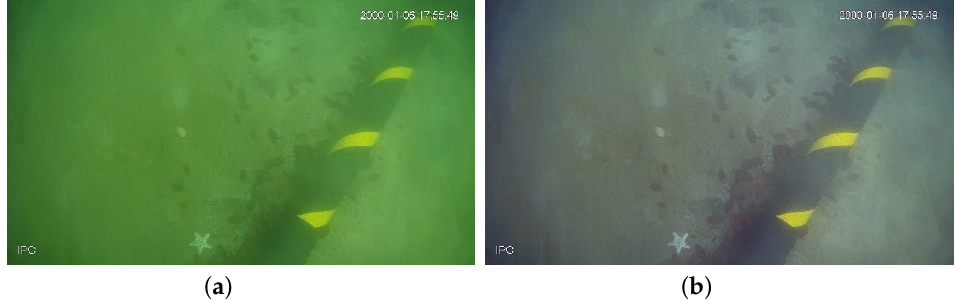
Figure 2. Example of the sample colour balance: ( a ) original image, ( b ) colour balance.